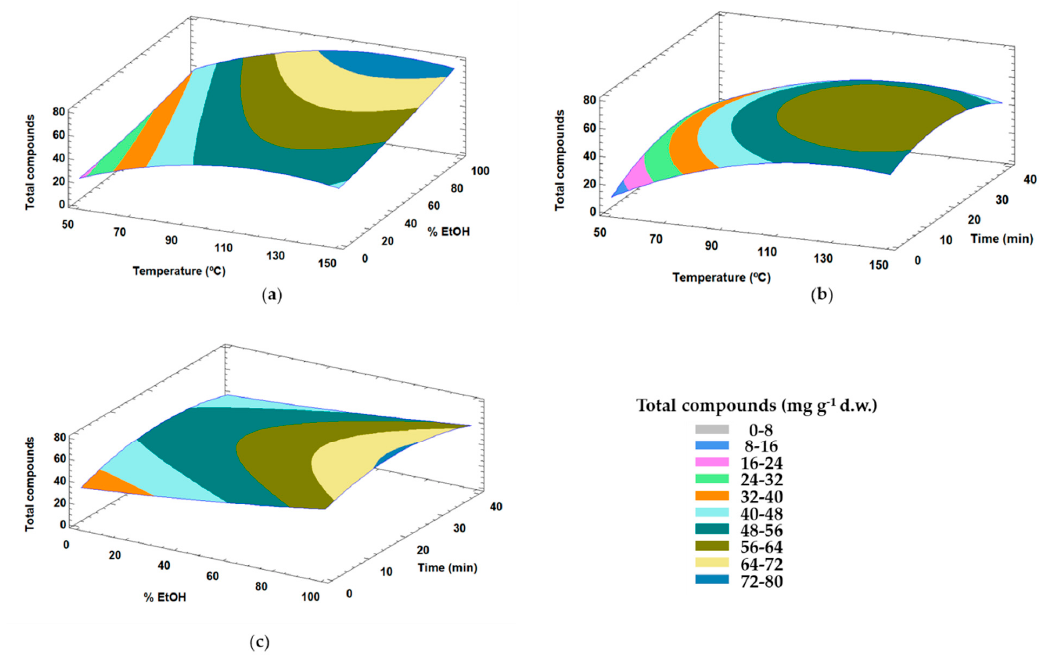
Figure 2. Response surface plots showing combined effects of process variables for total compounds: Temperature (°C)–% EtOH ( a ), temperature (°C)–time (min) ( b ) and % EtOH–time (min) ( c ). The fitted equation of the model for total compounds with the significant MAE parameters of X 1 Optimal conditions for the MAE of olive leaves have been reported previously in other (temperature), X 2 (% EtOH), X 11 (quadratic of temperature) and X 33 (quadratic of time) can be seen below. The fitted equation of the model includes the effect of time (X 3 ) (Equation (1)): Total compounds = − 57.8562 + 1.55431X 1 + 0.231443X 2 + 1.38944X 3 − 0.00630364X 11 −